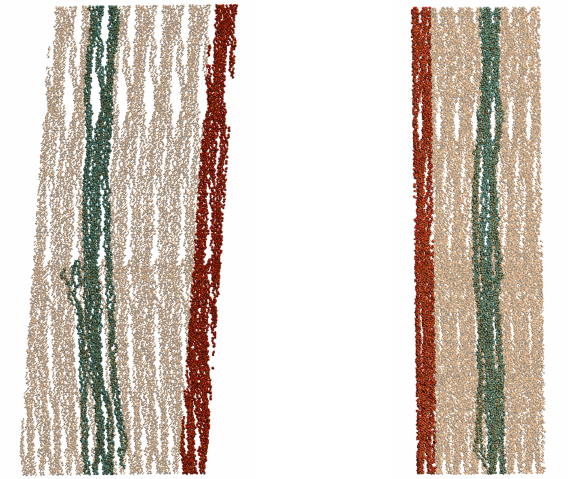
Figure A3. Extraction of CLG NanoFiber (blue) from the seven-by-seven periodic replication (orange transparent) of the CLG Fibril (red). View of xz-plane ( left ) and yz-plane ( right ) in